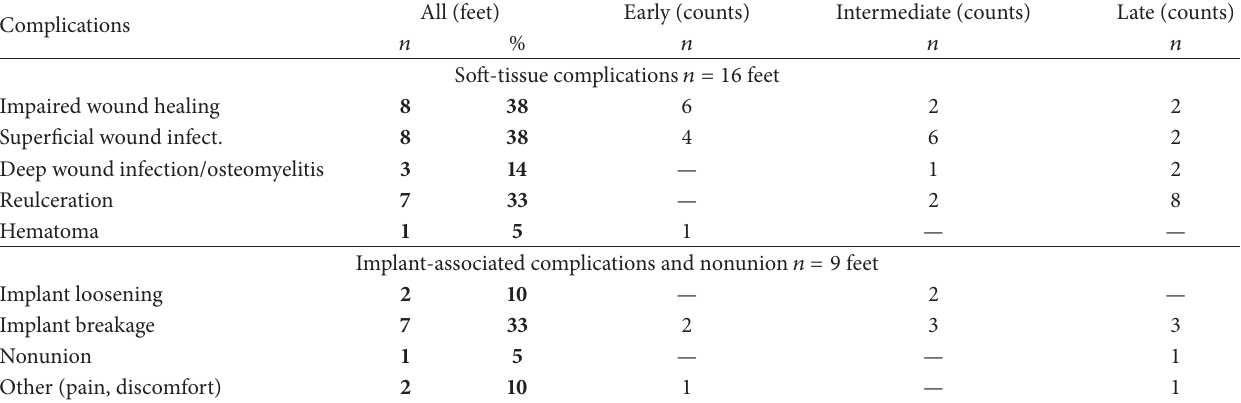
Table 2: Complications in study